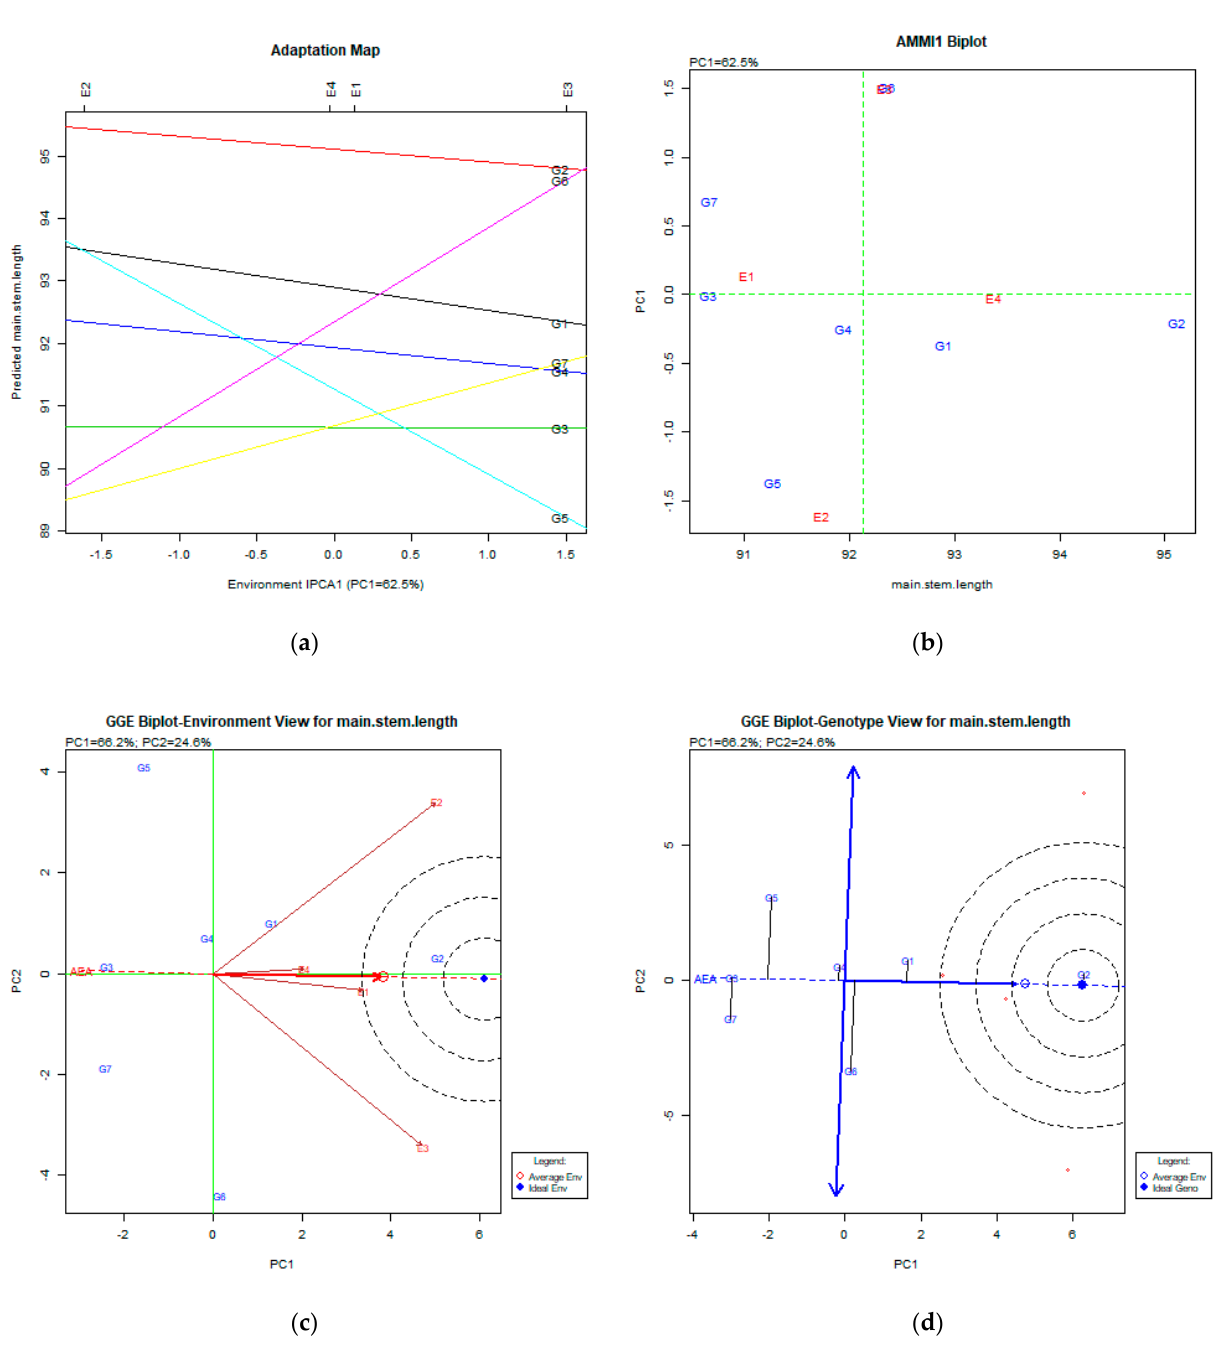
Figure 2. Stability analysis for the trait of main stem length (cm) based on ( a ) adaptation map, where the environmental stability of the genotypes is visualized by the X − axis (PC1) and the performance of the trait for the genotypes is tested by the Y − axis; ( b ) AMMI1 biplot, where the environmental stability of the genotypes is visualized by the X − axis (PC1) and the performance of the trait for the genotypes is tested by the Y − axis; ( c ) GGE biplot depicting the environmental stability over time for the desirable genotypes placed near the ideal environment; ( d ) GGE biplot for genotypes depicting the genotypic stability in different environments. The desirable genotypes are those placed near the concentric region of the ideal genotype.